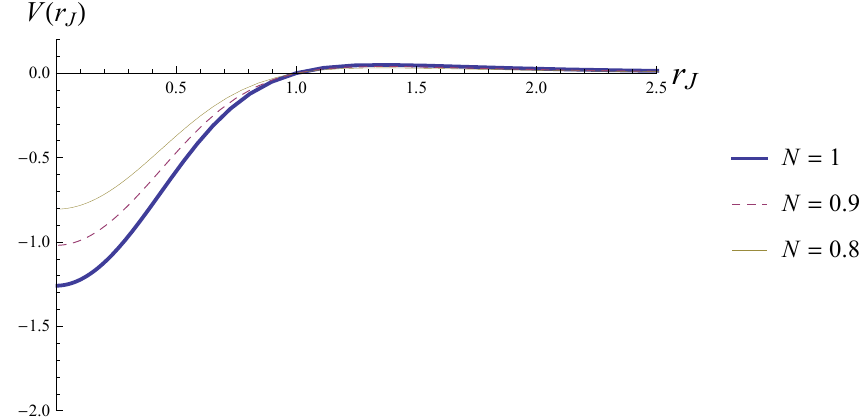
) in the Jordan frame for H = 1/2 and N = 1, 0.9, J